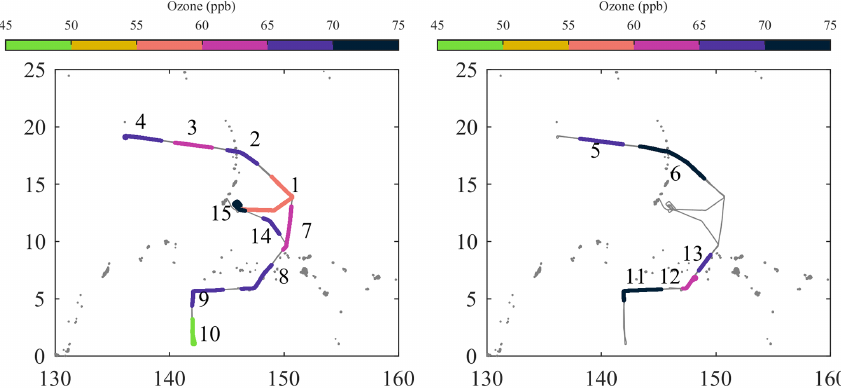
Figure 15. Flight track of RF01 with each profile coloured by mean tropospheric ozone as in Fig. 12. The profiles that would otherwise be obscured by other profiles are shown on the right-hand plot.